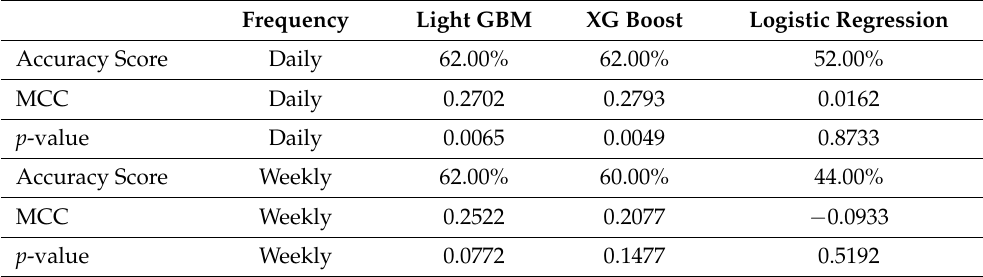
Table 7. Test scores. Numbers are truncated to four decimal places or two decimal places in percent form.